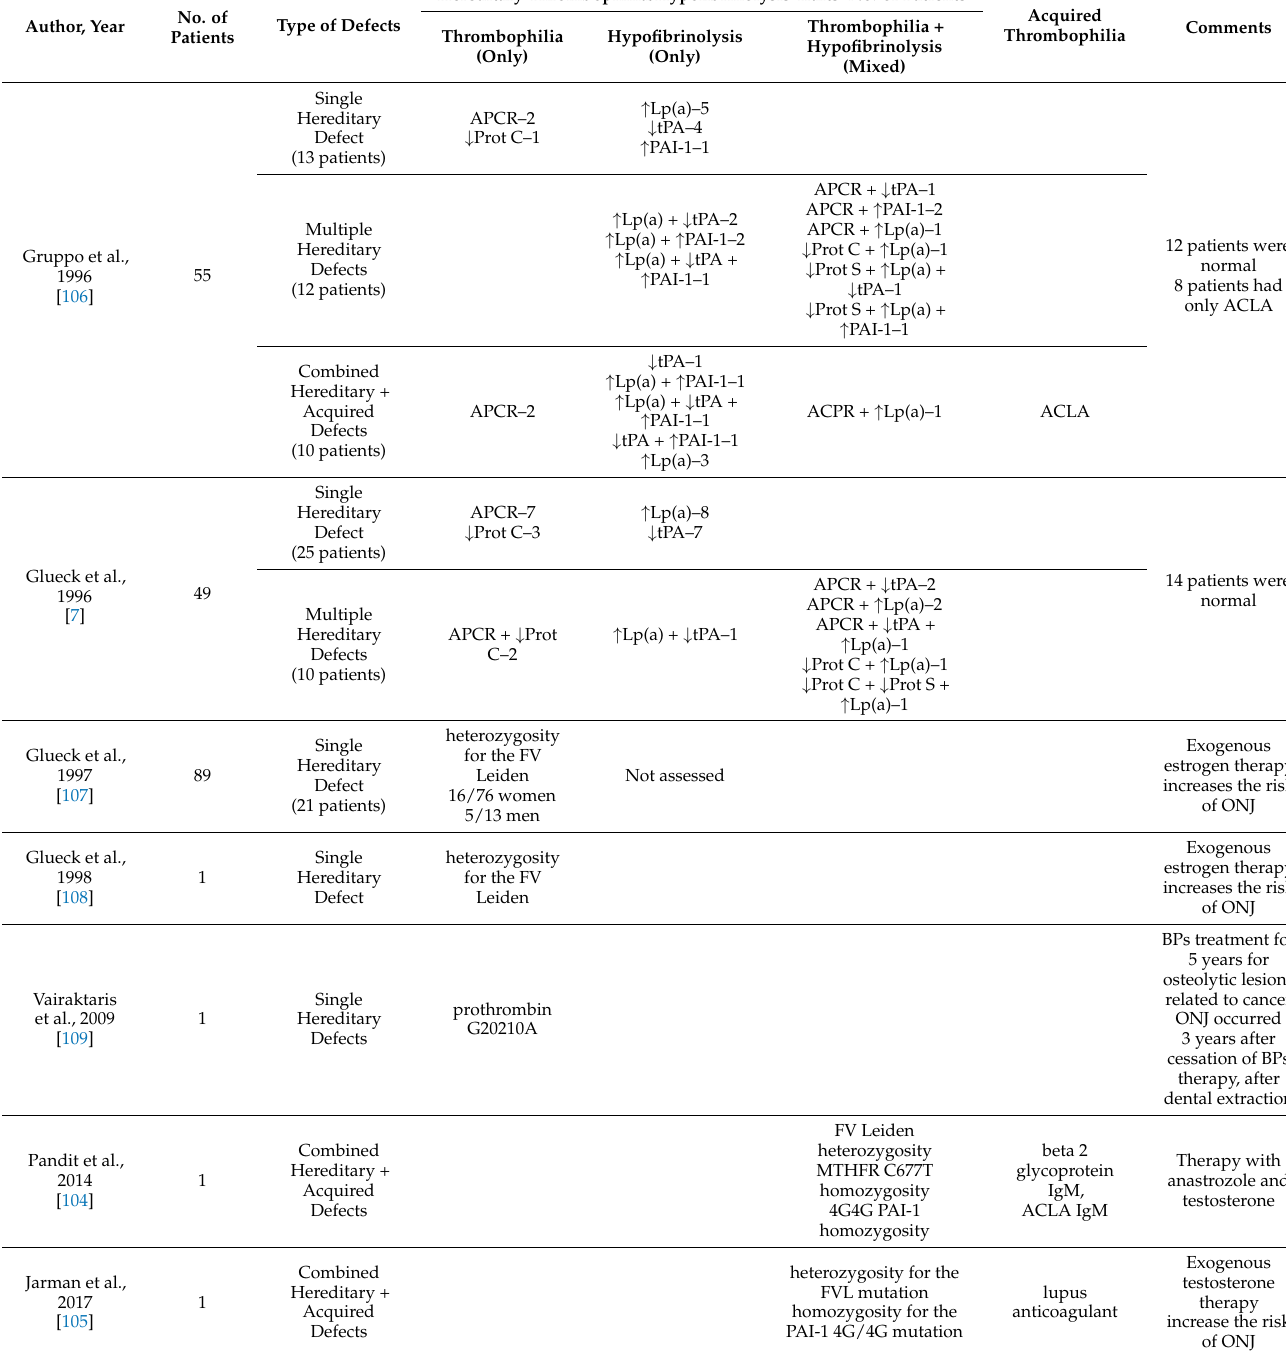
Table 1. Studies on hereditary thrombophilia/hypofibrinolysis in patients with